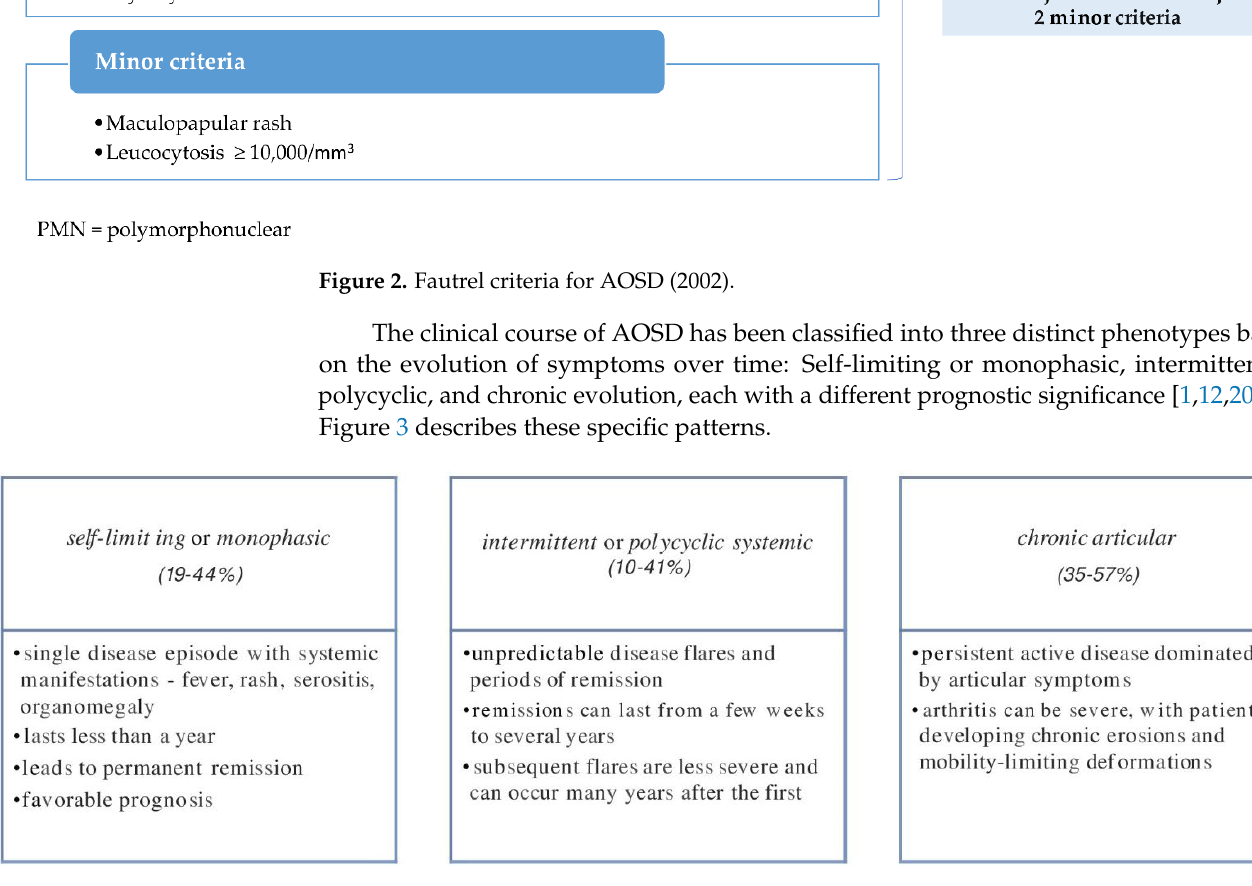
Figure 3. AOSD evolution patterns.